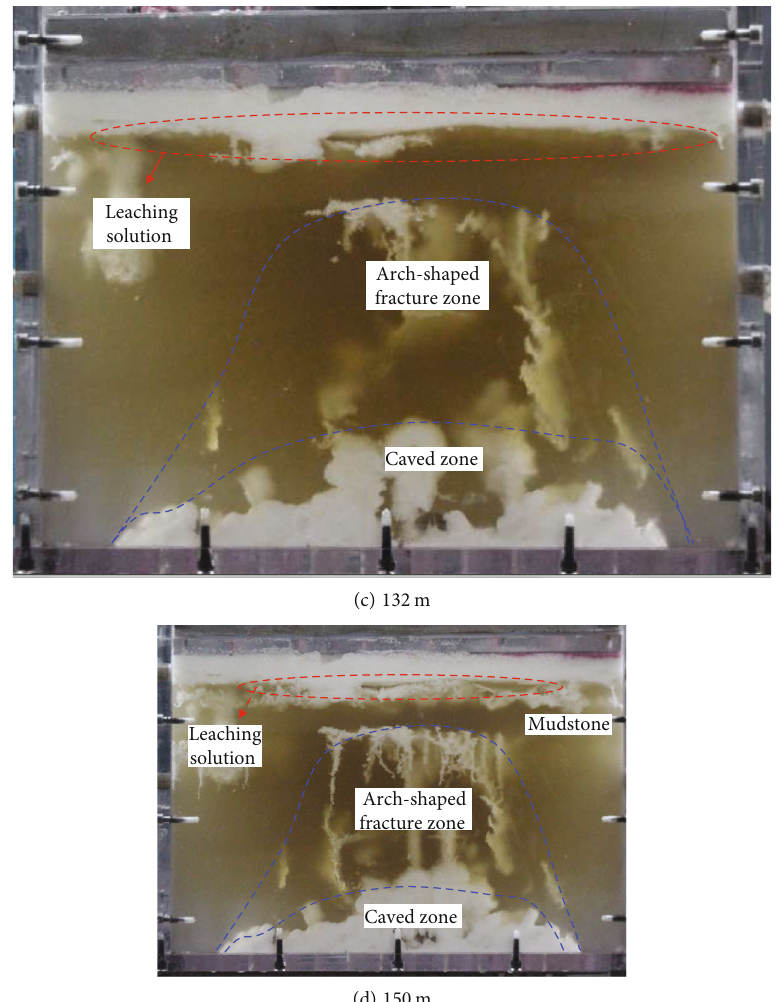
Figure 6: Development of fracture fi eld and migration of leaching